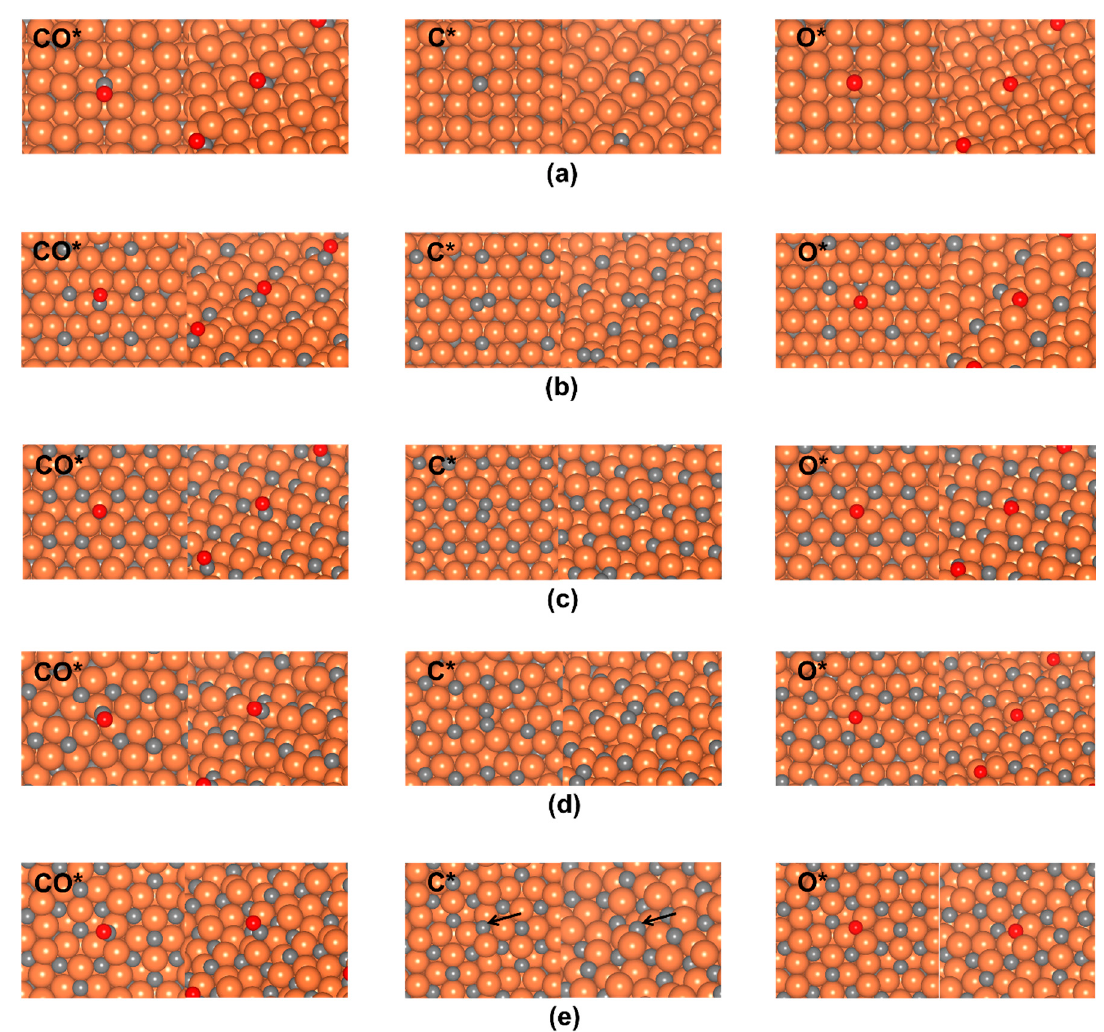
Figure 3. Top and angled views of CO*, C*, and O* on o-Fe 7 C 3 (001) surfaces with different terminations: ( a ) (001) 0.85 , ( b ) (001) 0.13 , ( c ) (001) 0.20 , ( d ) (001) 0.09 , and ( e ) (001) 0.99 . Orange, gray, and red balls in the figure represent Fe, C, and O, respectively. Arrow in (e) points toward C*.